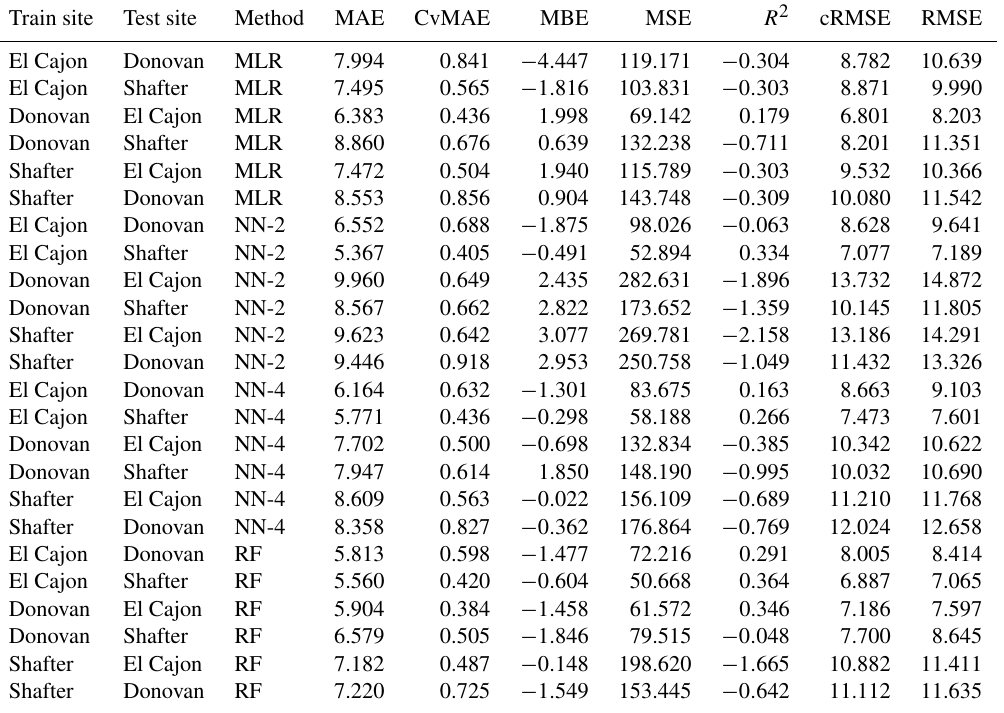
Table C6. Level 1 test results for NO 2 .